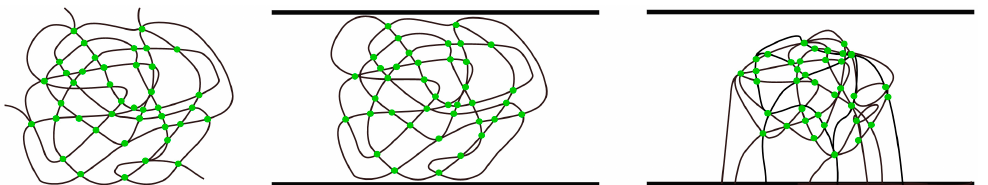
Figure 12. A scheme of the simulated systems: free chains in a solution (system A, left ), free chains in a slit (system B, middle ) and chains grafted to one wall of the slit (system C, right ). Intra- and inter-polymer cross-links are marked as green points.